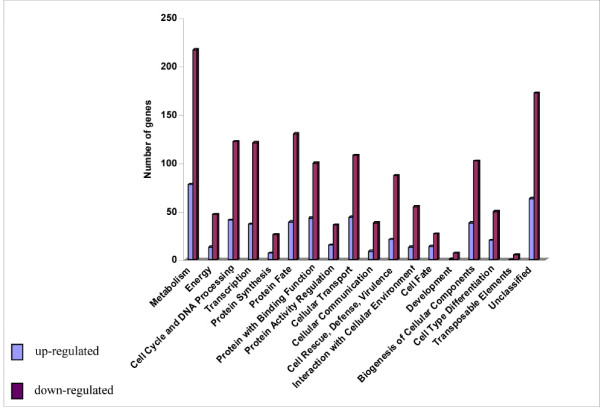
IPS functional classification of the list of 1006 significant genes that respond to LSMMG that are not general environmental stress response genes as identified by Gasch et al., 2000. Black bars represent genes that are up-regulated, gray bars represent the down-regulated genes.